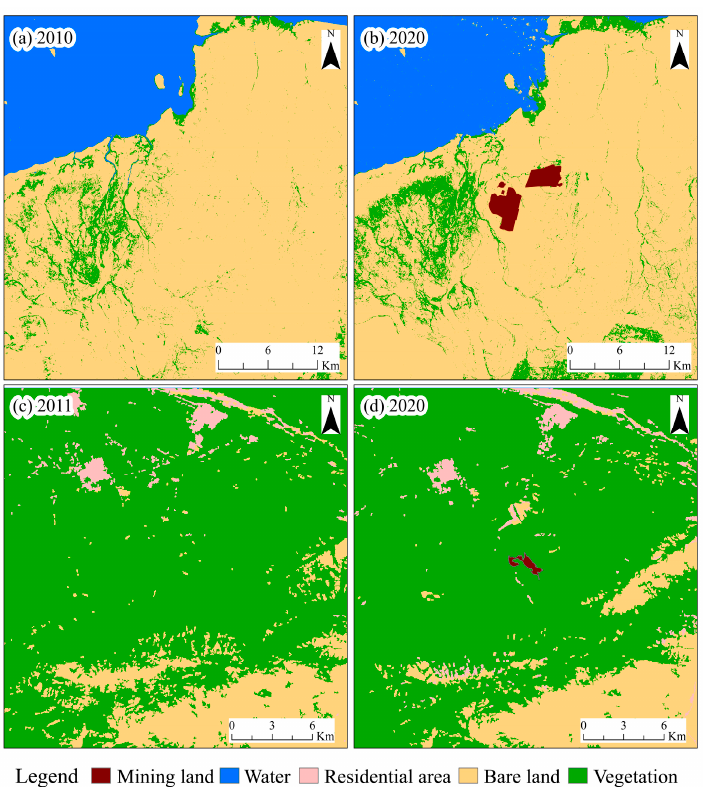
Figure 6. Distribution of ecological resources in the monitoring area ( a , b ) for Sino Iron and ( c , d ) for Taldybulak Levoberezhny. Table 5. Ecological resources in the monitoring area of Sino Iron.